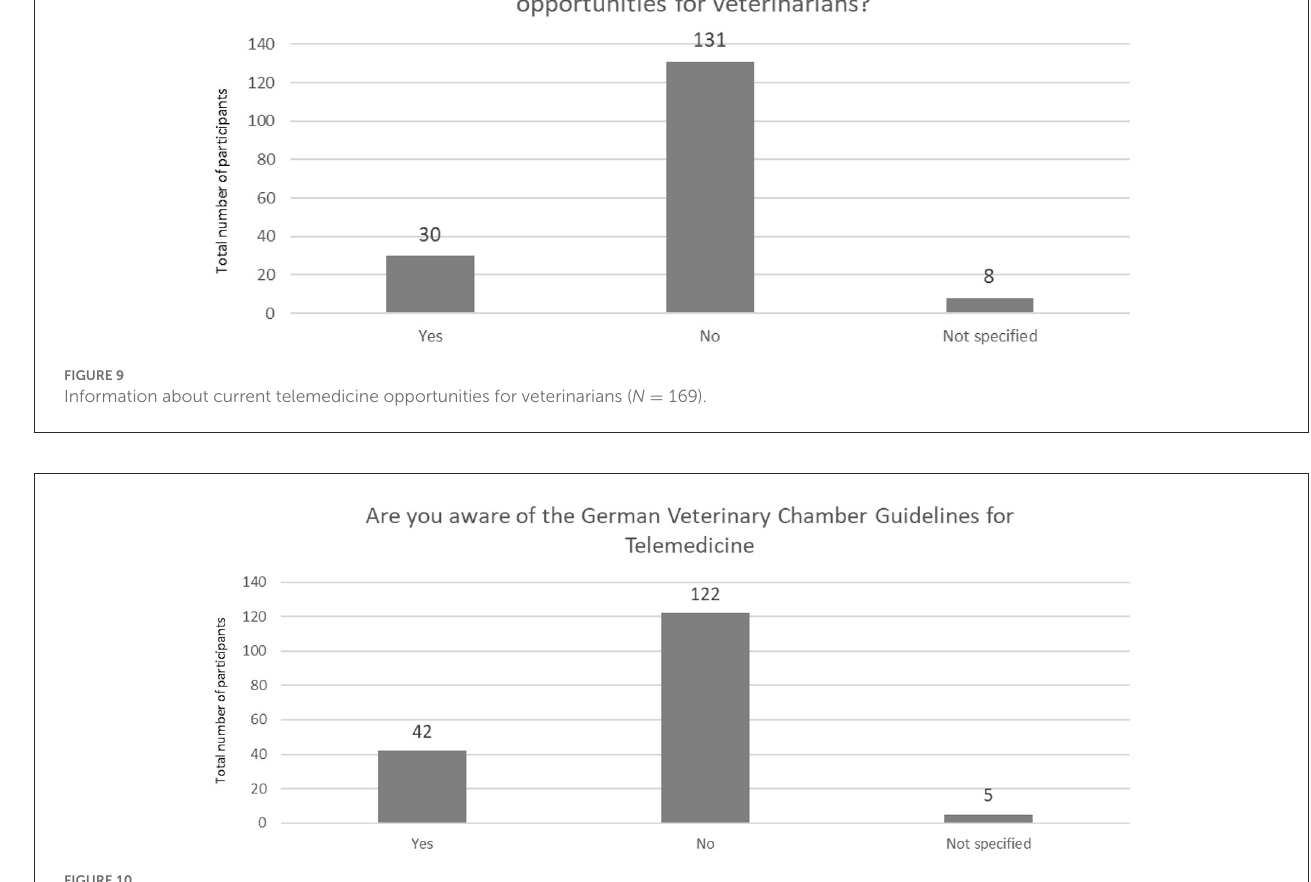
FIGURE10 Awareness of the German veterinary chamber guidelines for telemedicine ( N =